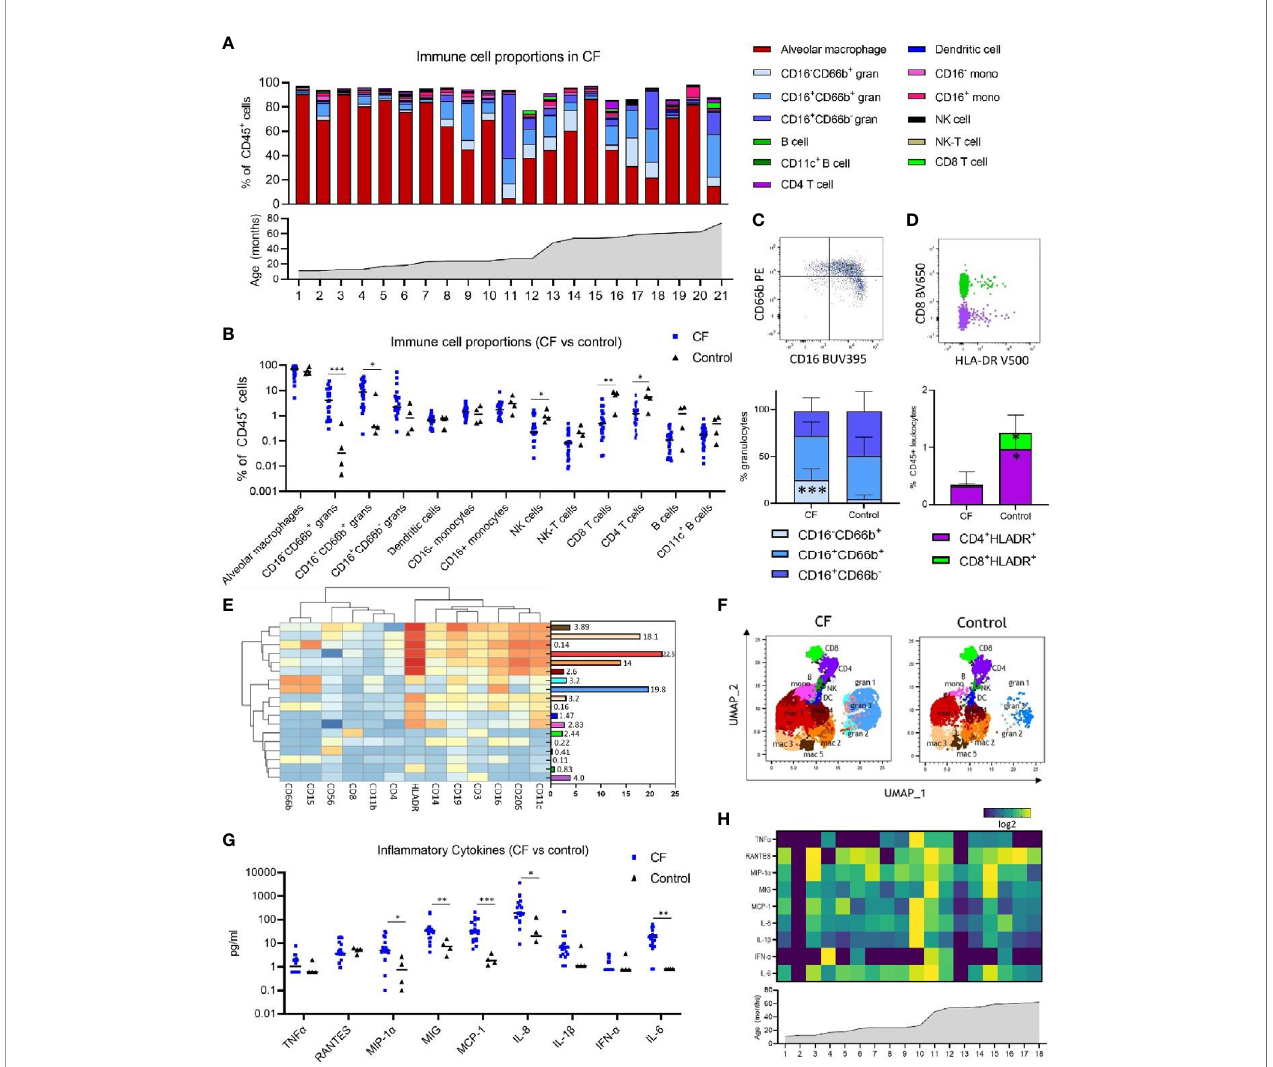
FIGURE 1 | Immune cell and in fl ammatory cytokine pro fi le of early life bronchoalveolar lavage (BAL) samples from children with cystic fi brosis (CF) and healthy controls. (A) Frequencies of BAL immune cell subpopulations expressed as percentage of CD45 + leukocytes and in ascending order of age in children with CF (n = 21). (B) Frequencies of immune cell subpopulations in BAL of children with CF (n = 21) and healthy controls (n = 4). (C) Granulocyte subpopulations in BAL of CF and control children, represented by a fl ow cytometry plot and the bar graph beneath (D) HLA-DR + CD4 and CD8 T cells in BAL of CF and control children, represented by a fl ow cytometry plot and the bar graph beneath. (E) FlowSOM clustering of BAL using 13 lineage markers revealed 18 cell clusters which have been annotated based on expression pattern and projected onto a (F) UMAP plot with colours corresponding to the annotated FlowSOM clusters. (G) Concentration of in fl ammatory cytokines in BAL of children with CF (n = 18) and healthy controls (n = 4). (H) Heatmap depicting individual BAL cytokine responses in 18 children with CF in ascending order of age. All p-values by Mann-Whitney U test, *p < 0.05, **p < 0.01, ***p <